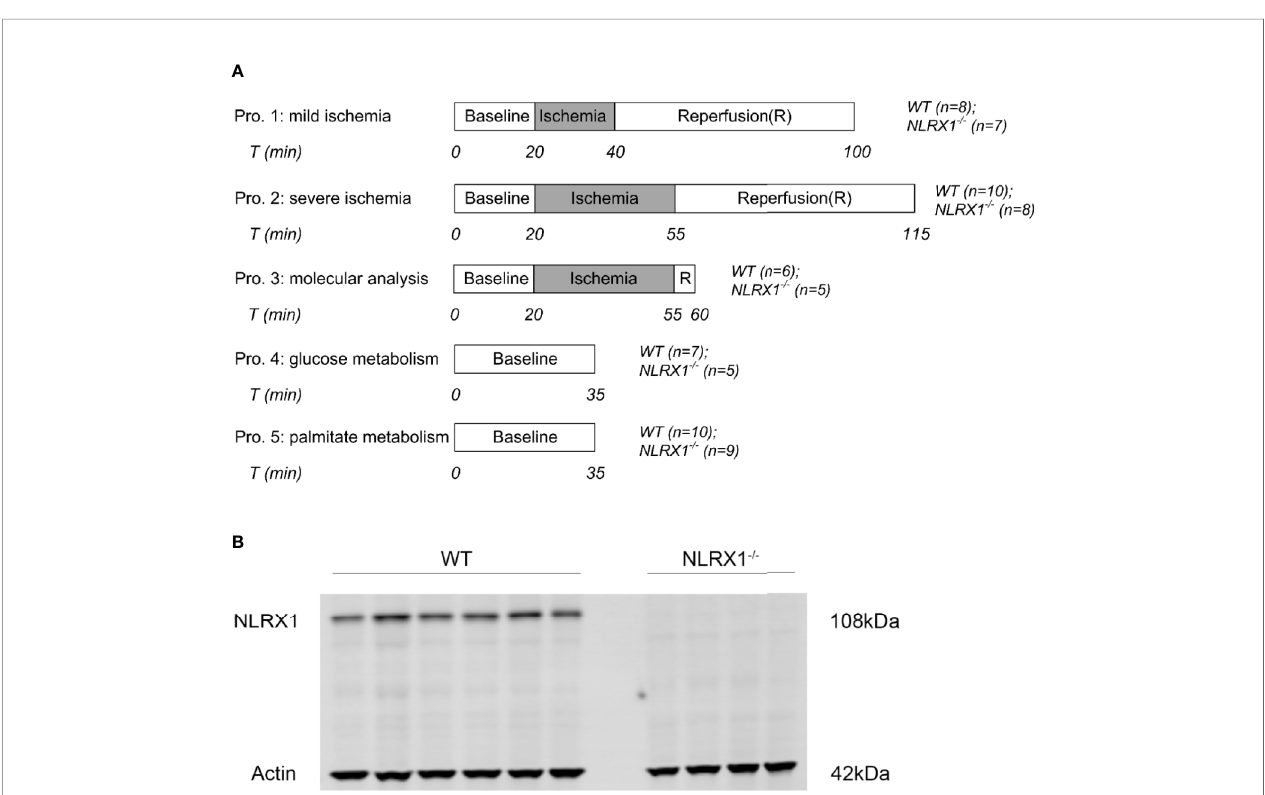
FIGURE 1 | (A) Perfusion protocols for NLRX1 effects on IR injury, survival kinases at reperfusion and 13 C cardiac metabolism. Hearts from WT mice and NLRX1 -/- mice were perfused with mixed substrates as described in methods part and subjected to 20 min baseline perfusion. For IR injury, hearts were subjected to 20 or 35 min ischemia followed by 60 min reperfusion. For measuring vital survival proteins, hearts were subjected to 35 min ischemia and 5 min reperfusion. For detecting metabolism, hearts were perfused for 35 min with either U- 13 C 6 glucose or U- 13 C 16 palmitate. (B) immunoblot results showing the presence of NLRX1 in WT hearts, and the absence of NLRX1 in NLRX1 - / -